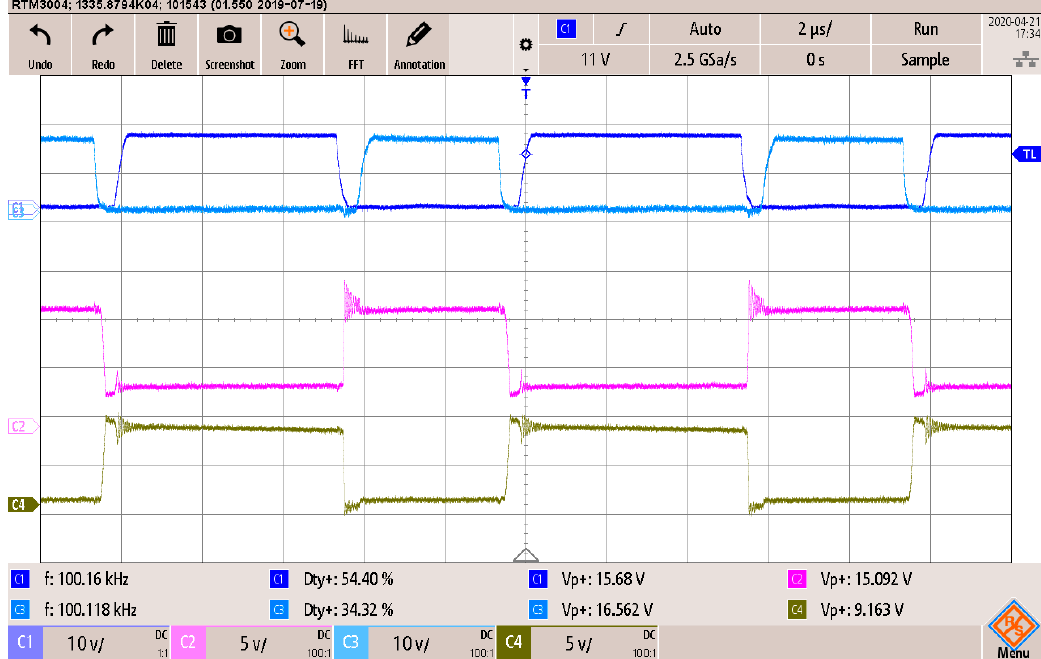
Figure 18. Waveforms of switch V GS , V DS and inductor current with input 10 V, output 12 V/1 A (CH1, I L ; CH2, V GS 1 ; CH3, V DS 1 ; CH4, V DS 2 ).